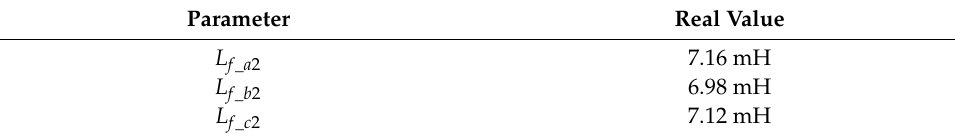
Table 7. Real values of the inductance L f of 7